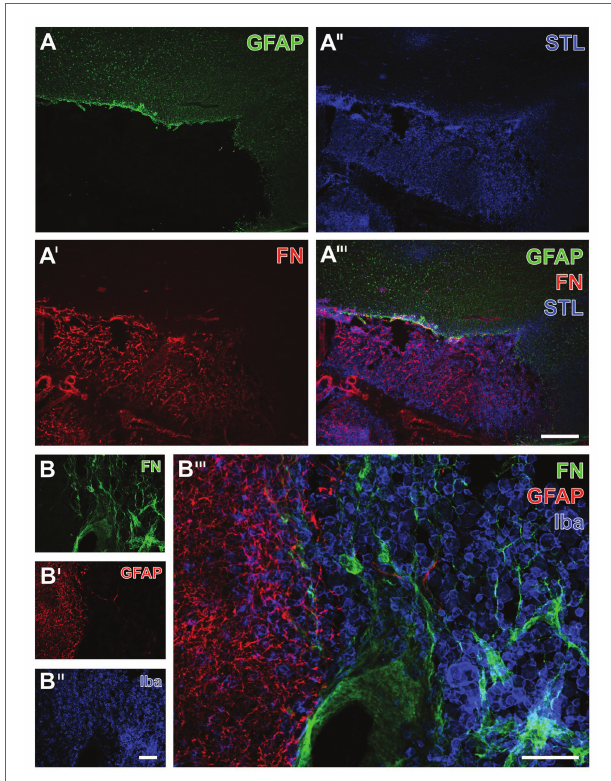
FIGURE 9 | Immunofluorescence-based detection of fibronectin, micro‐ and astroglia as well as the vasculature in sheep subjected to 14 days of experimental focal cerebral ischemia. Numerous astrocytes as visualized by the GFAP (A) with a condensation at the ischemic border zone probably indicate the expected glia scar (A) , which is strictly separated from the immunosignal of fibronectin (FN, A ' ) that appears in the ischemic area. As revealed by potato lectin (STL, A '' ), this area also contains several cells presumably representing macrophages in addition to endothelial structures. The overlay verifies the complementary staining patterns of FN and the GFAP-positive astroglia (A ''' ) . At higher magnification, the FN immunoreactivity remains not restricted to vessels but is also visible in the surrounding tissue (B) ; however, nearly disappearing in the area covered by GFAP-positive astroglia (B ' ) , which becomes clearly visible in the overlay of staining patterns (B ''' ) . Concomitant labeling with antibodies directed against Iba (B '' ) visualizes microglia and mainly infiltrated macrophages in the area of ischemia affection that is immunopositive for FN (B,B ''' ) . Scale bars: in A ''' (also valid for A , A ' , and A '' ) = 500 μ m, in B ''' = 100 μ m, in B '' (also valid for B and B ' ) = 100 μ m.